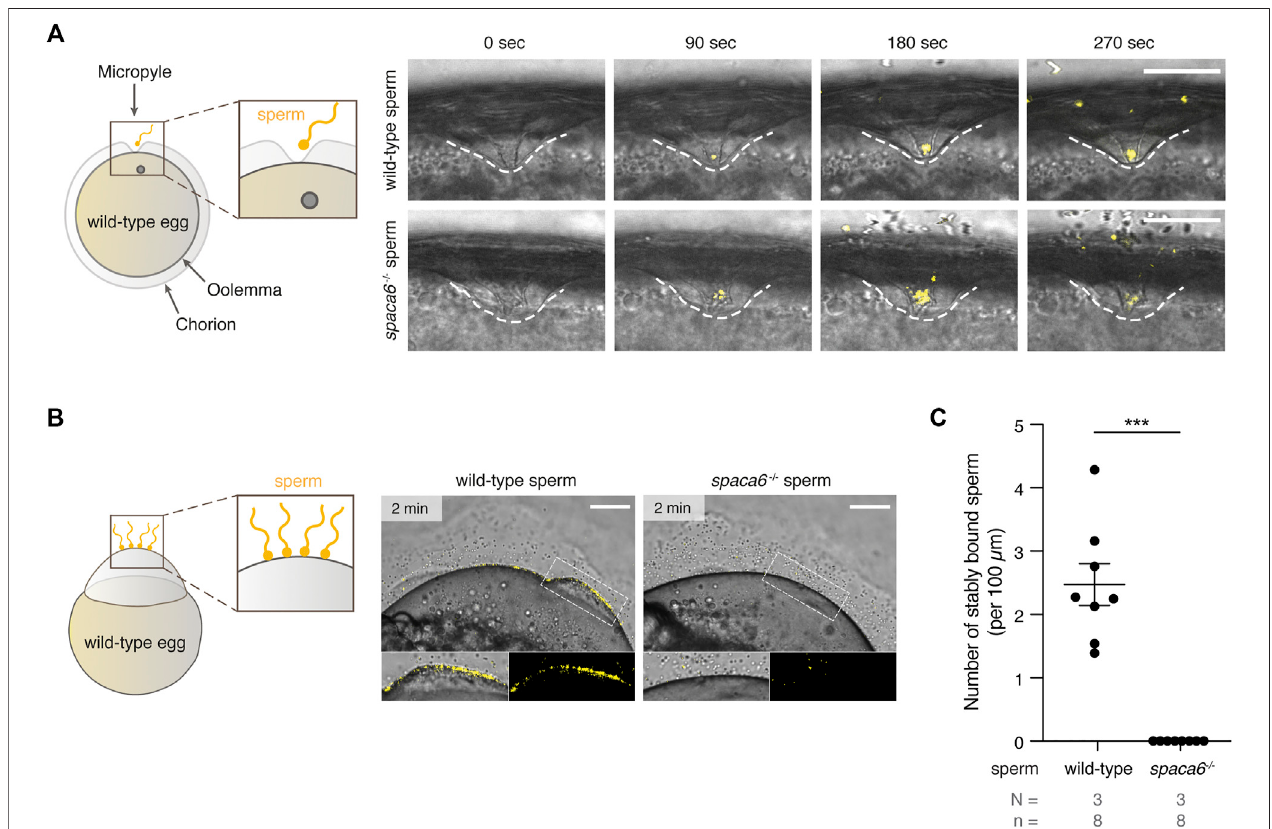
FIGURE4| Zebra fi shSpaca6isessentialforsperm-eggbinding. (A) .Time-lapseimagesofspermapproachingthemicropyleofwild-typeeggs.Left:Experimental setup. Right: Representative time series of MitoTracker-labeled wild-type (top) and spaca6 − / − (bottom) sperm (yellow) approaching the micropyle (white dashed lines). Scale bar (cid:1) 50 μ m. (B) . Sperm binding assay. Left: Experimental setup. Wild-type and spaca6 − / − sperm were labeled with MitoTracker (yellow) and subsequently incubatedwithactivatedanddechorionatedwild-typeeggs.Right:Representativeimagesofwild-type(top)and spaca6 − / − (bottom)spermbindingtothesurfaceof theegg2 minafterspermaddition.Theboxedregionisshownathighermagni fi cationbelow.Scalebar (cid:1) 100 μ m. (C) .Quanti fi cationofspermbinding.Bindingofsperm to the egg was quanti fi ed by assessing the number of stably bound sperm per 100 μ m over a period of 2 min. Wild-type sperm were frequently found bound to the oolemma. ***, p < 0.001 (Mann-Whitney test); error bars, SD; N (cid:1) number of independent experiments; n (cid:1) number of sperm.